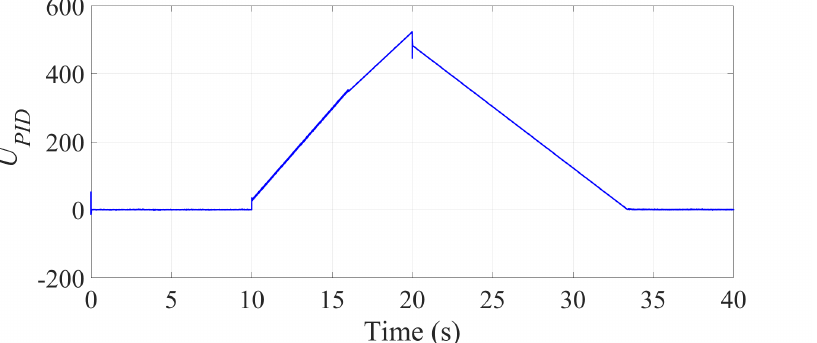
Figure 13. Scenario 2: Control input to generate the duty cycle of a PWM signal using a classical PID controller (simulation 1).